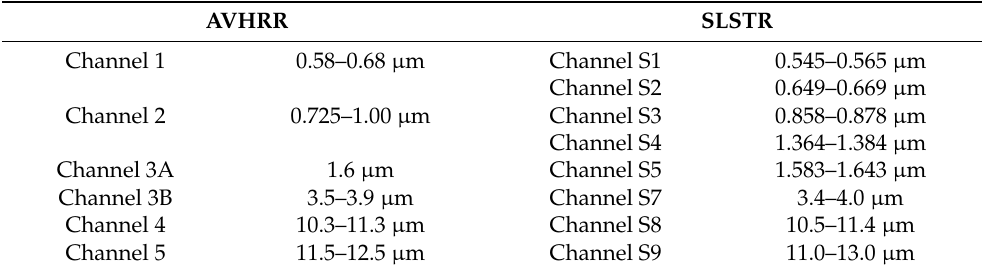
Table 1. Comparison of spectral sensitivity ranges of related channels for AVHRR and the SLSTR instruments.